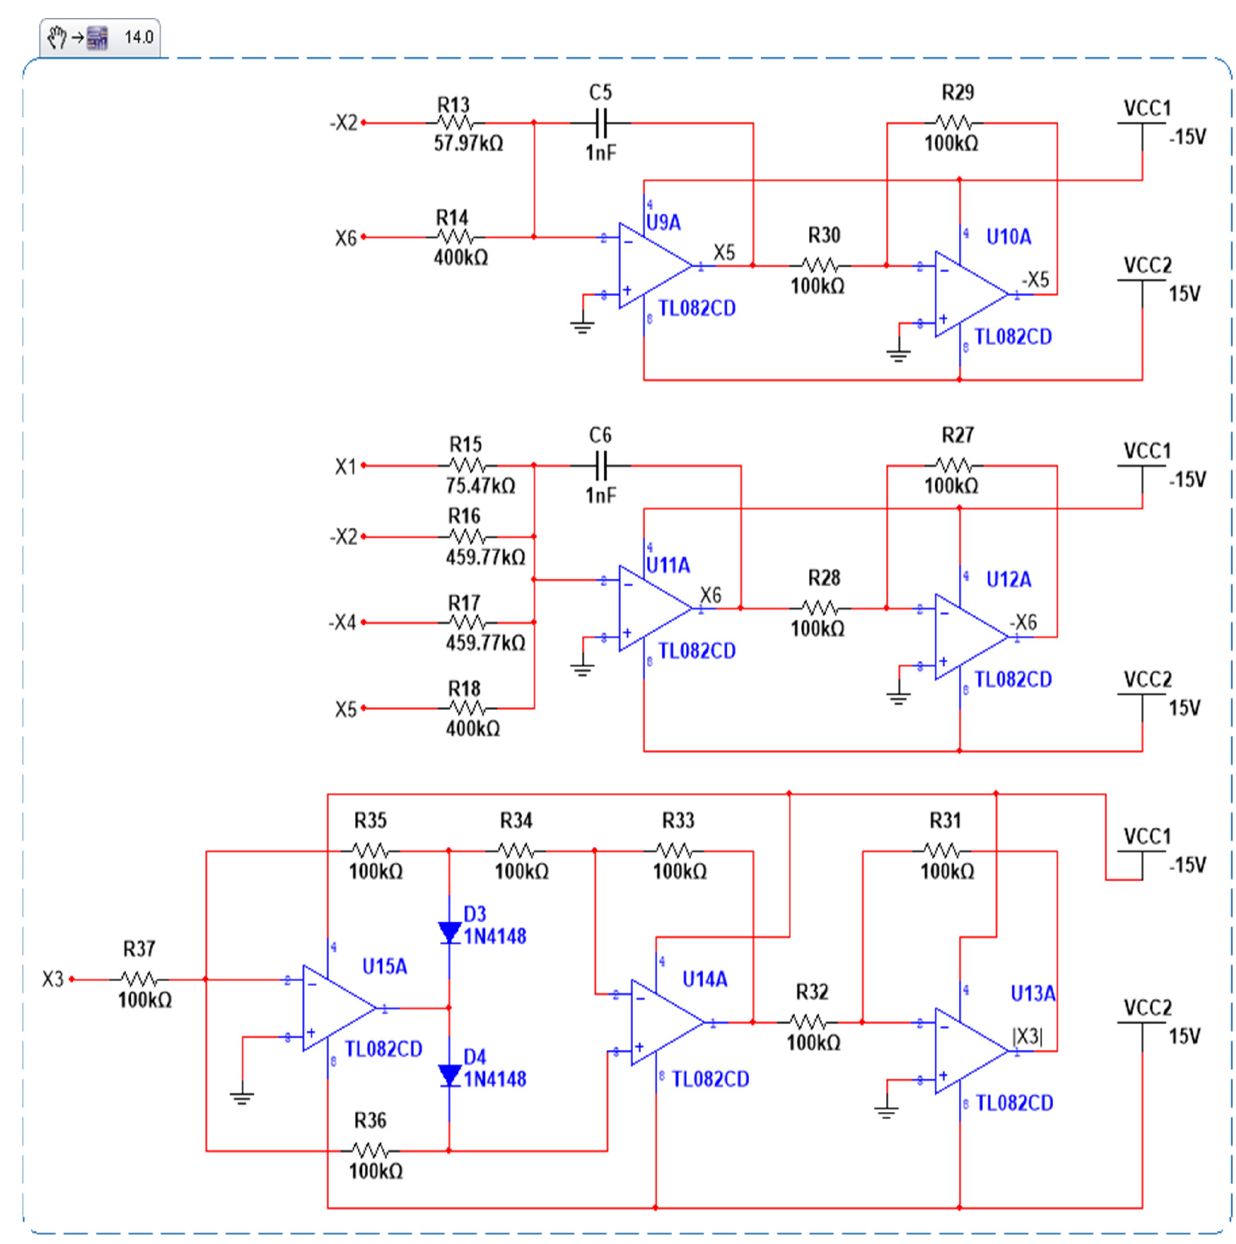
Figure 4. Circuit realization of the new hyperchaotic system (43) .